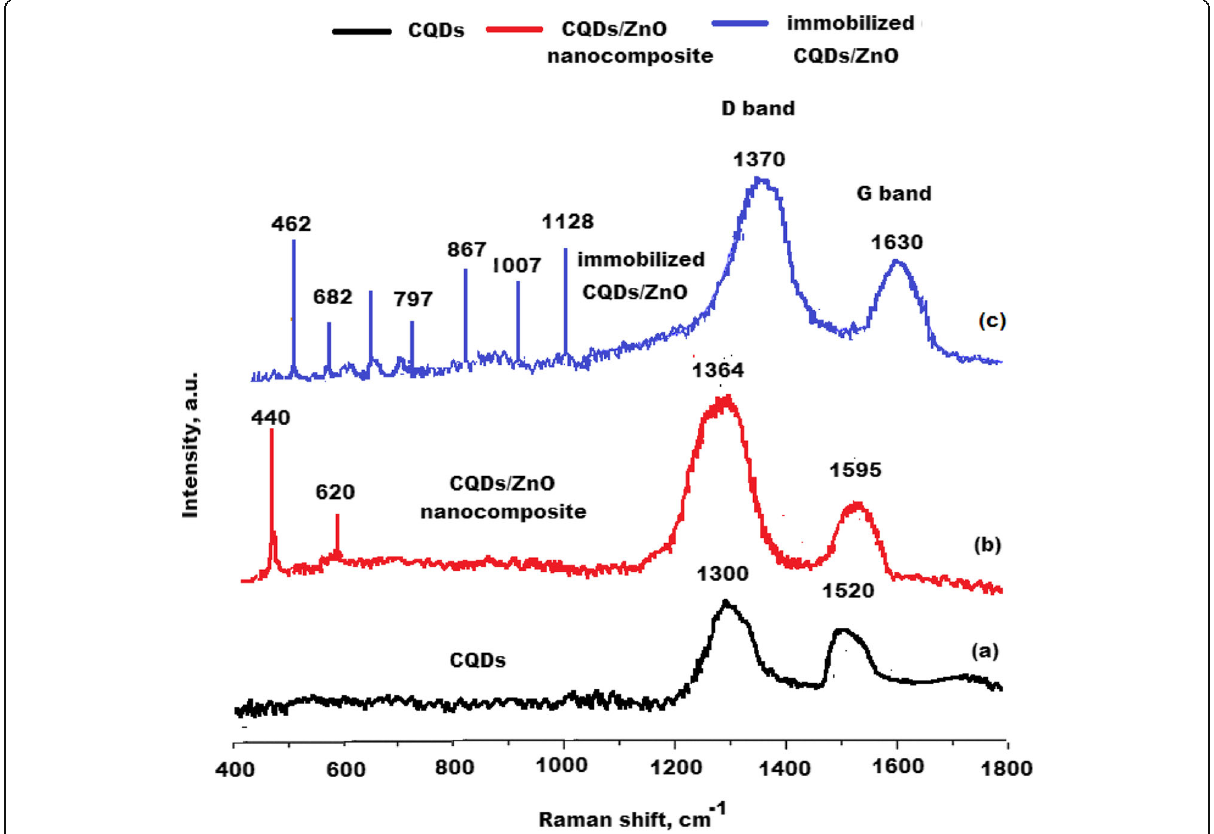
Fig. 8 Raman spectra shift of a CQDs, b CQDs/ZnO nanocomposite, and c immobilized CQDs/ZnO-BM 19.21